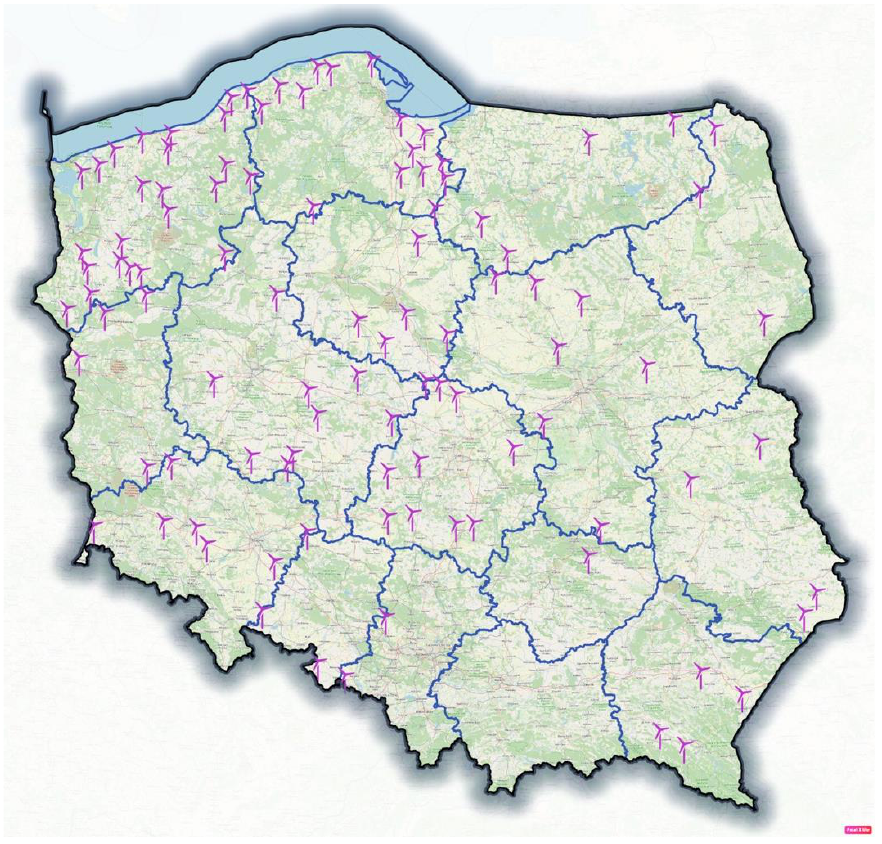
Figure 6. Localisation of wind turbine clusters (2382 pieces) in Poland with full description according to the data given from open-access sources (Table S1).